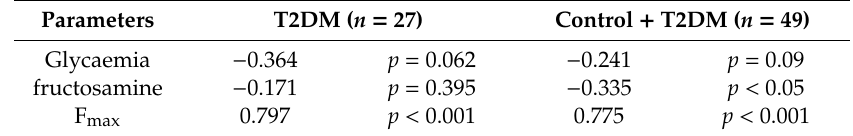
Table 3. The correlation coe ffi cients (R S ) for the maximal clot formation velocity (V max ) and selected parameters in T2DM patients, and the overall group of examined subjects (control volunteers + T2DM patients).